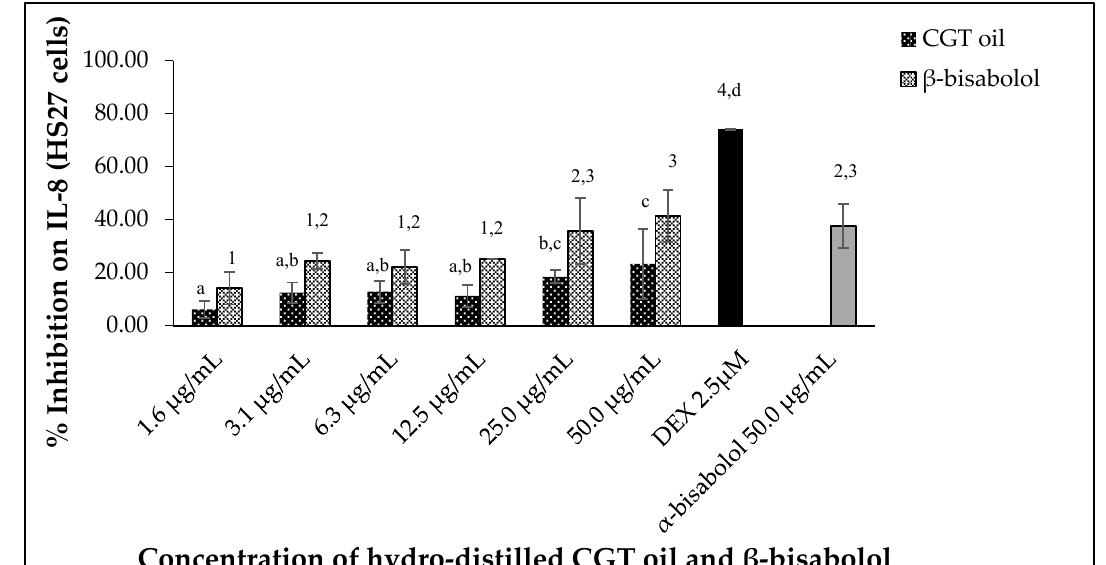
Figure 7. Effect of CGT oil and β -bisabolol dilutions on IL-8 production in HS27 cells. HS27 cells were exposed to test extracts or compounds for 1 h and then induced with 100 ng/mL lipopolysaccharide (LPS) for IL-8 production ( n = 3). Values are expressed as mean ± SD. Duncan’s multiple range test between average IL-8 production across the different concentrations indicates that dissimilar letters/numerals denote a significant difference ( p ≤ 0.05).